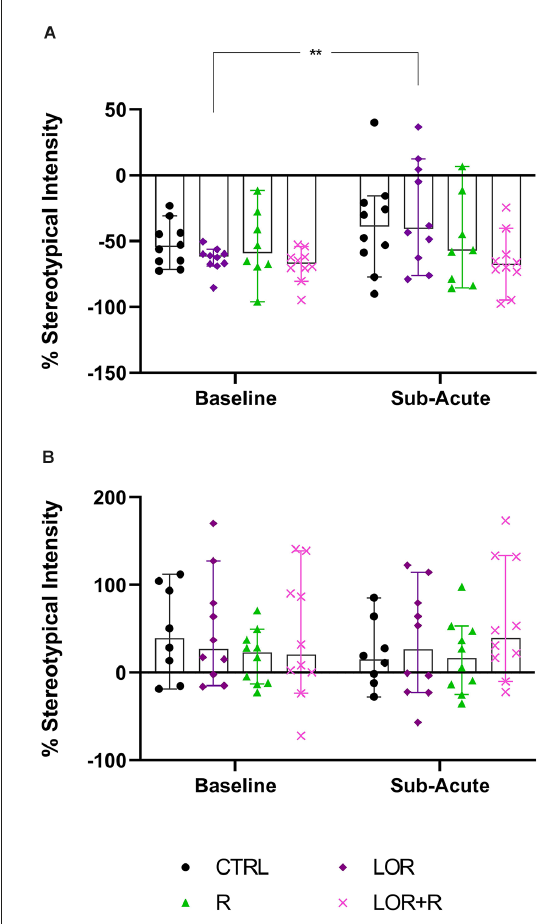
FIGURE5 Average time spent engaging in HS behavior at the sub-acute phase by (A) NS and (B) HS mice exposed to CTRL, R, L, LOR+R. 2-way RM ANOVA followed by Bonferroni’s multiple comparisons tests. Data represent the median ± 95CI. * p < 0.05; CTRL, control (drug- and restriction-naïve animals); R, behavioral restriction; L, lorazepam; LOR+R, lorazepam combined with behavioral